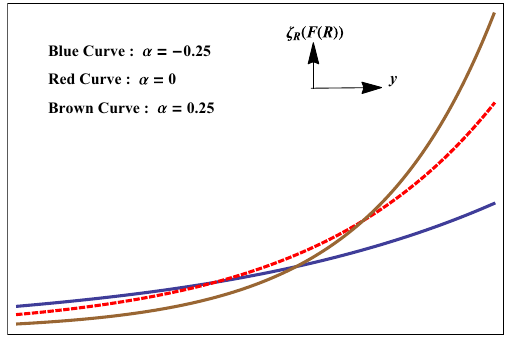
Fig. 1 ζ L , R ( = ζ L , R ( F ( R )) in the diagram) vs. y for M = 1, (cid:9) = − 1 and m 5 = 0